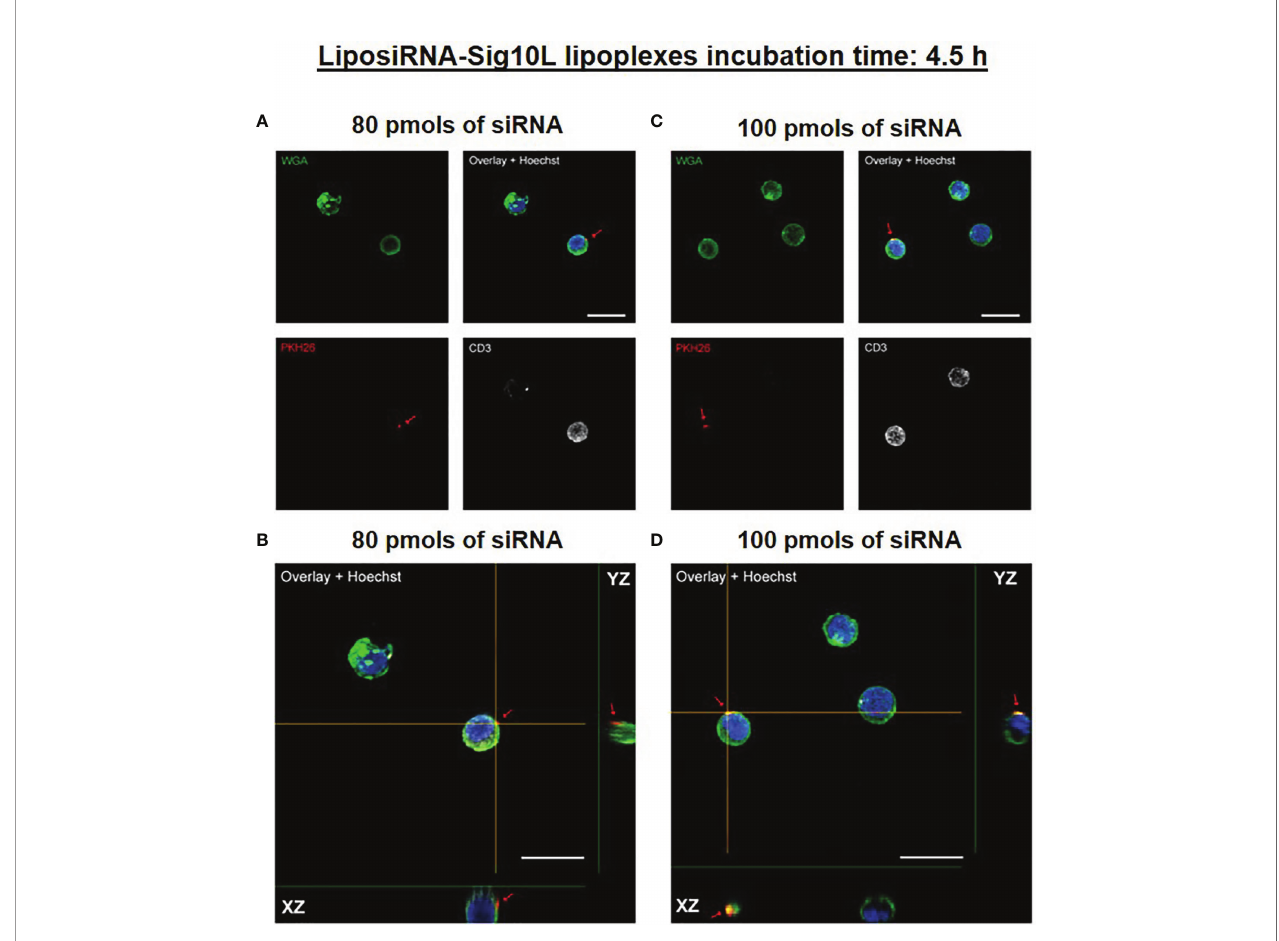
FIGURE 1 | PKH26-labeled LiposiRNA-Sig10L (L-siRNA-Sig10L) internalization in HD PBMC after 4.5 h of incubation. Confocal microscopy images show the internalization of LiposiRNA-Sig10L particles (PKH26 positive dots, arrows) in CD3 + (white) cells among HD PBMC after 4.5 h of treatment with lipoplexes at 80 (A) and 100 (C) pmols of siRNA. Confocal Z reconstructions show the distribution of PKH26-labeled LiposiRNA-Sig10L particles beneath the cell membrane in CD3 + lymphocytes (arrows) upon treatment with different doses of lipoplexes 80 (B) and 100 (D) pmols of siRNA. Cell membrane and nuclei are stained with WGA (green) and Hoechst dye (blue) respectively. Bar: 10 m